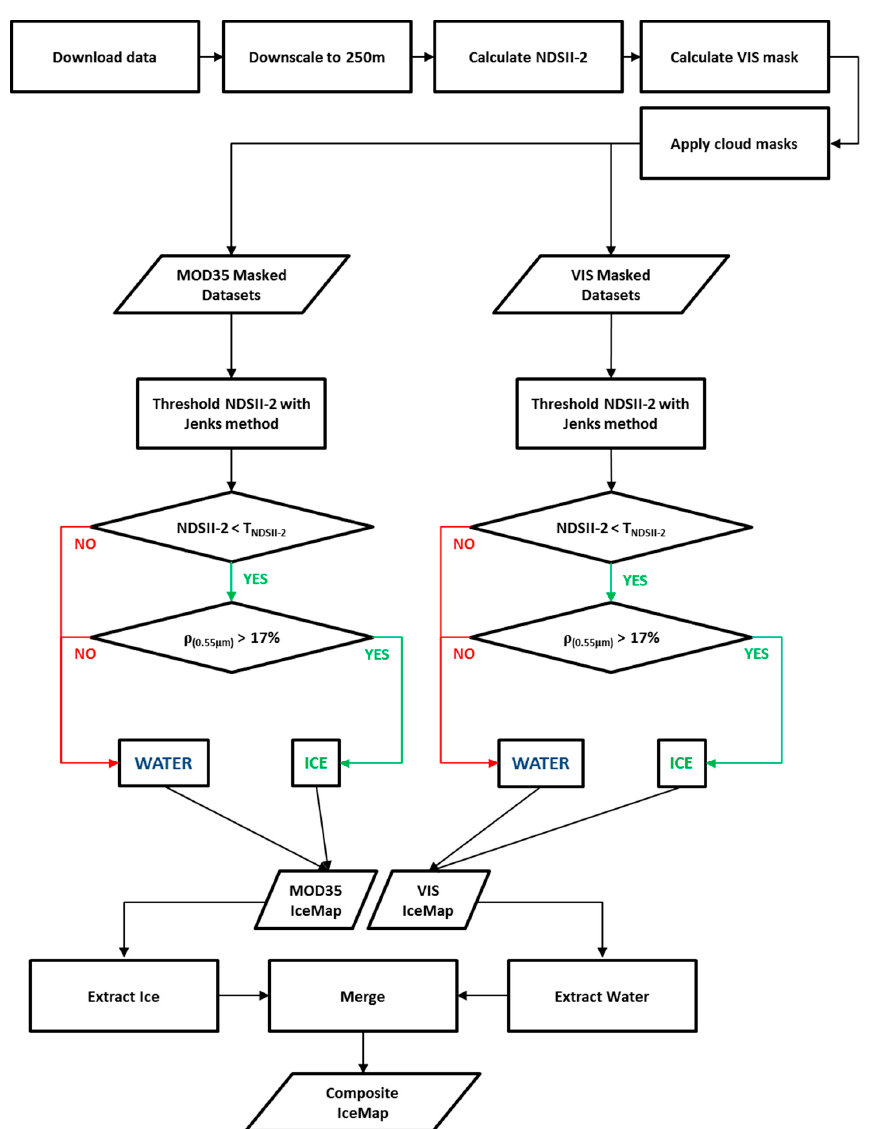
Figure 3. Processing flowchart of the IceMap250 algorithm. In this figure, ρ (0.55 μ m) represents the TOA reflectance in the green band, and T NDSII-2 is the threshold of NDSII-2 obtained using the Jenks natural breaks method.